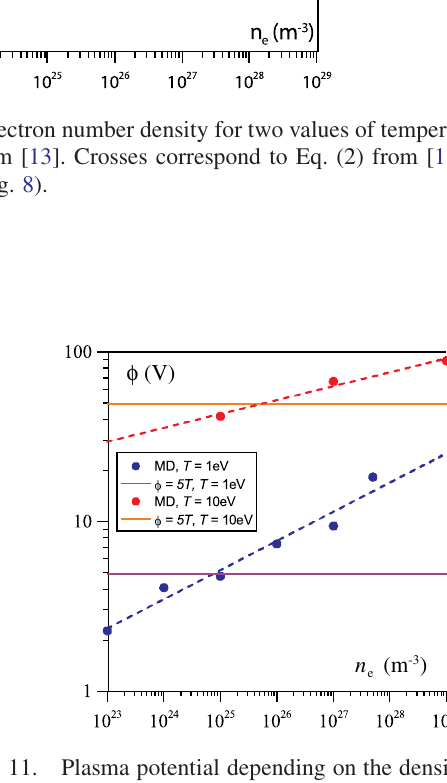
FIG. 11. Plasma potential depending on the density for differ- ent temperatures. MD results are compared with the theoretical estimations from [13].